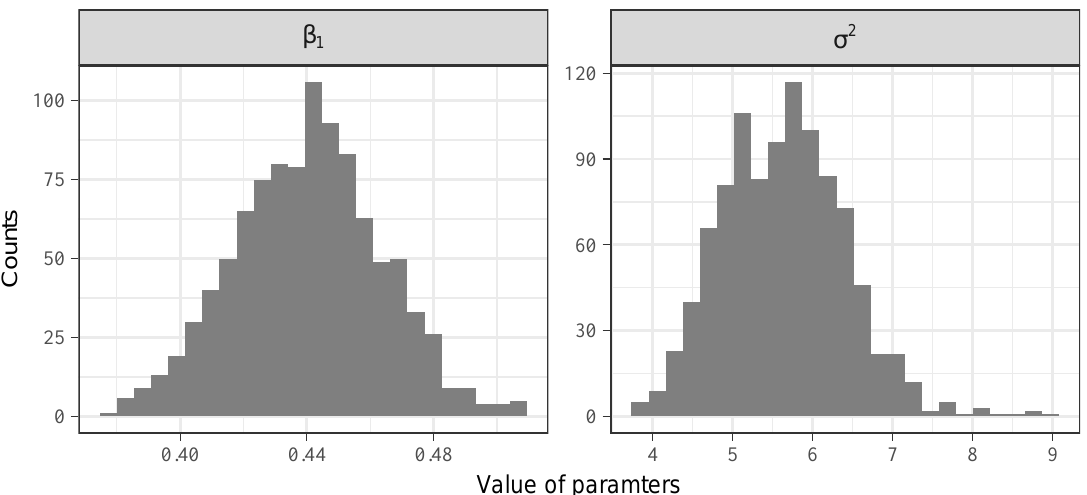
Figure 8. The posterior distributions of the coefficient of LST ( β 1 ) and the spatial variance ( τ 2 ) of the daytime model in January.